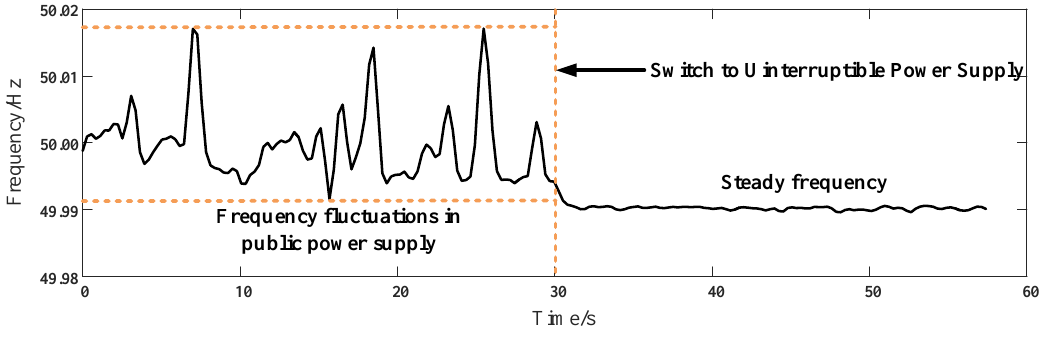
Figure 13. Base frequency changes during the measuring process. During 0–30 s, the network is